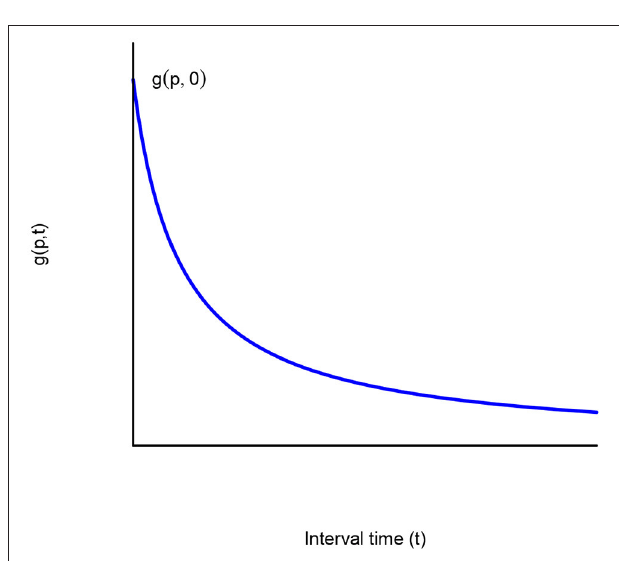
FIGURE 2 | A regular discount function. Source: own elaboration.